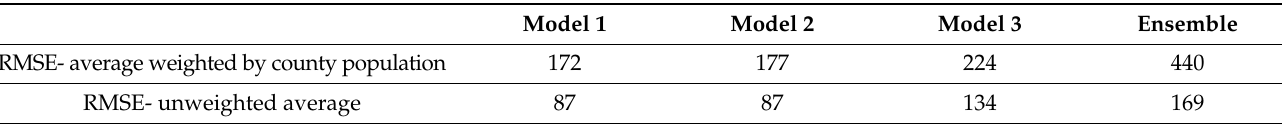
Table 5. RMSE values of prediction models over 4 weeks and all